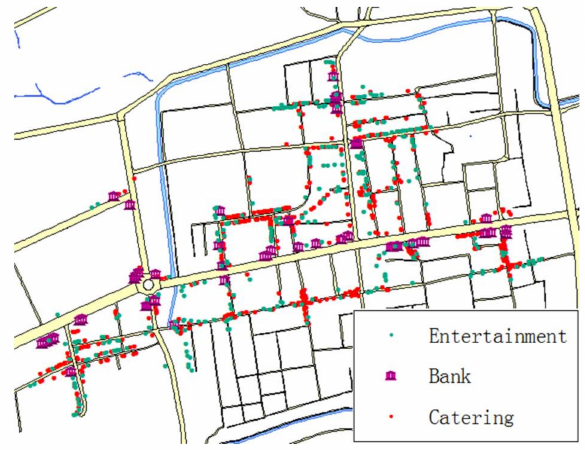
Figure 11. The distribution for the rule { 2,3 } ⇒